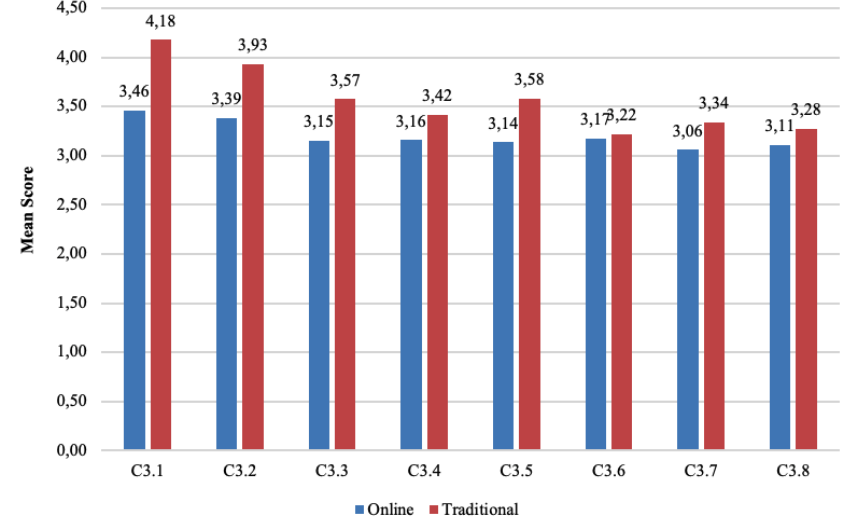
Figure 3: Effectiveness of traditional